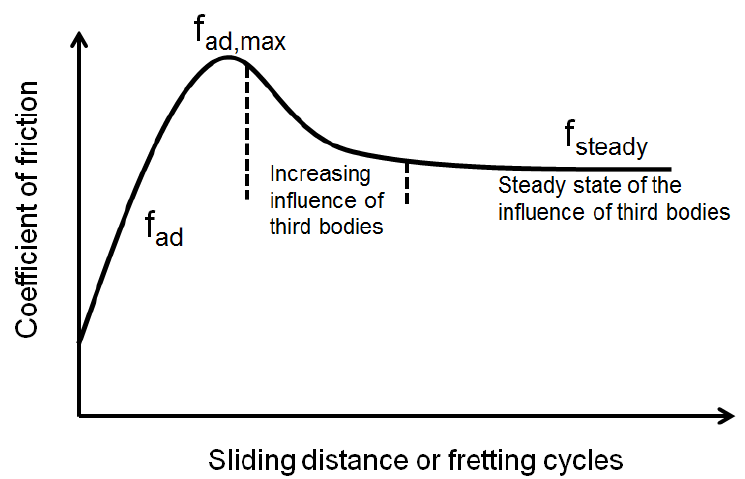
Figure 2. Development of coefficient of friction in a wear process, f ad : the coefficient of adhesive friction; f ad,max : maximum value of f ad ; f steady : the steady coefficient of friction.